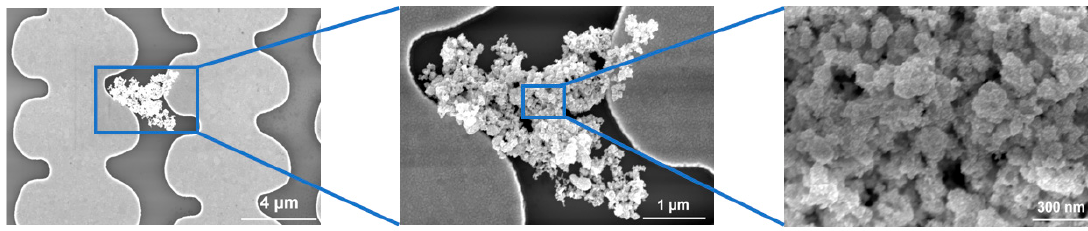
Figure 2. SEM images after drop-casting deposition of 3-mercaptopropionic acid functionalized gold nanoparticles (MPA-AuNP).